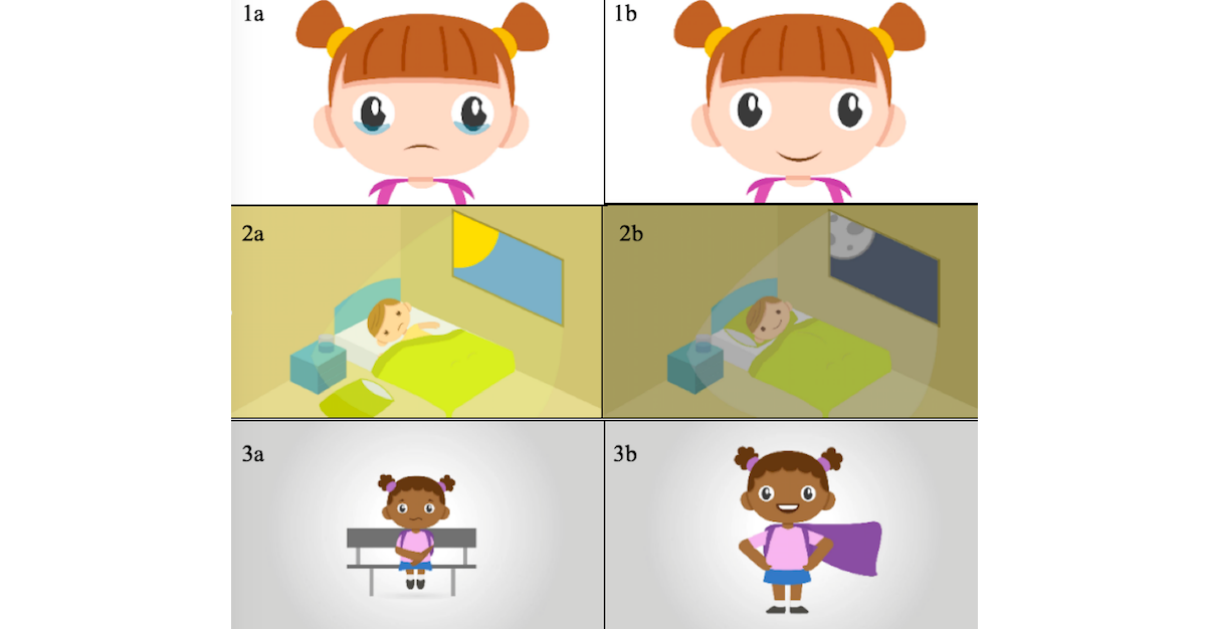
Figure 1. Screenshots from early versions of the pilot animations. Images 1a and 1b show paired animations for the construct Sad or Depressed. Images 2a and 2b reflect the construct Sleep Problems. Images 3a and 3b reflect the construct